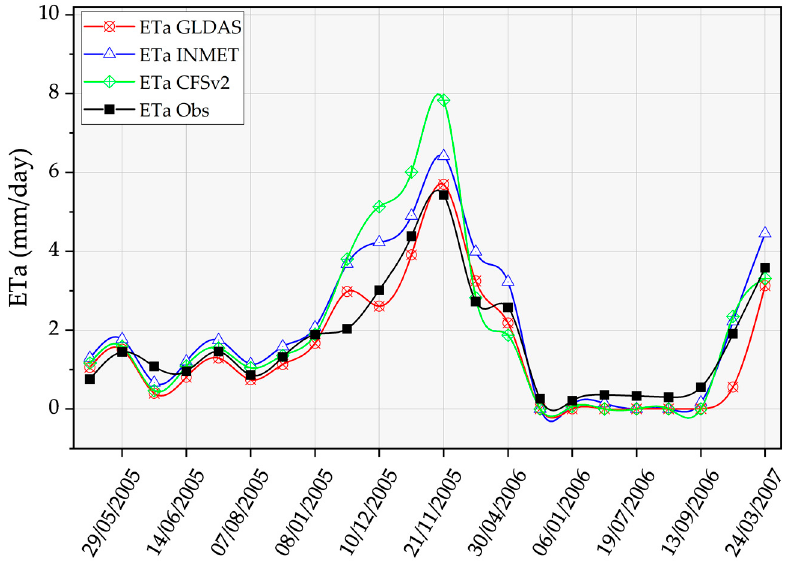
Figure 6. ETa profile estimated by SSEBop-Br model for the three sources of meteorological data (GLDAS, INMET, and CSFv2) and ETa observed in a flux-tower